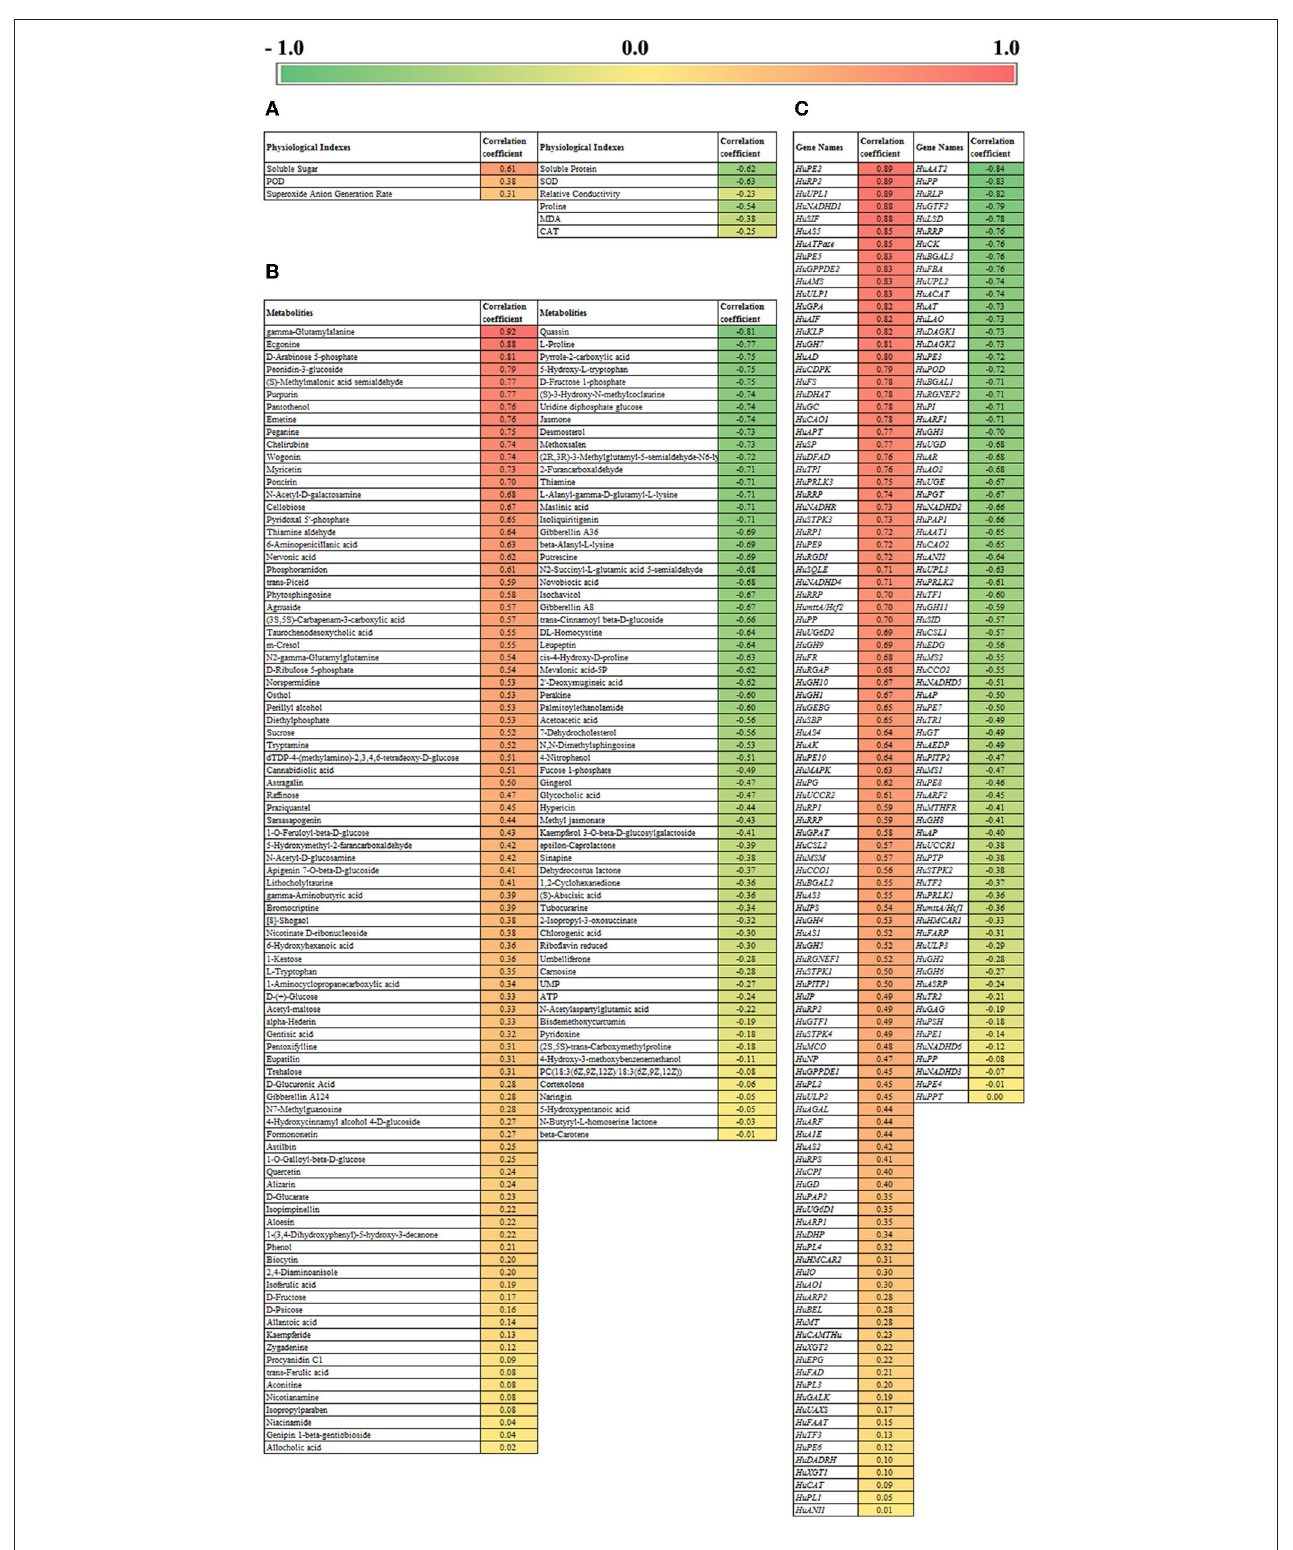
FIGURE 8 | Correlation analysis of pollen germination rate with physical and chemical index (A) , metabolomics (B) , and transcriptomics (C) .